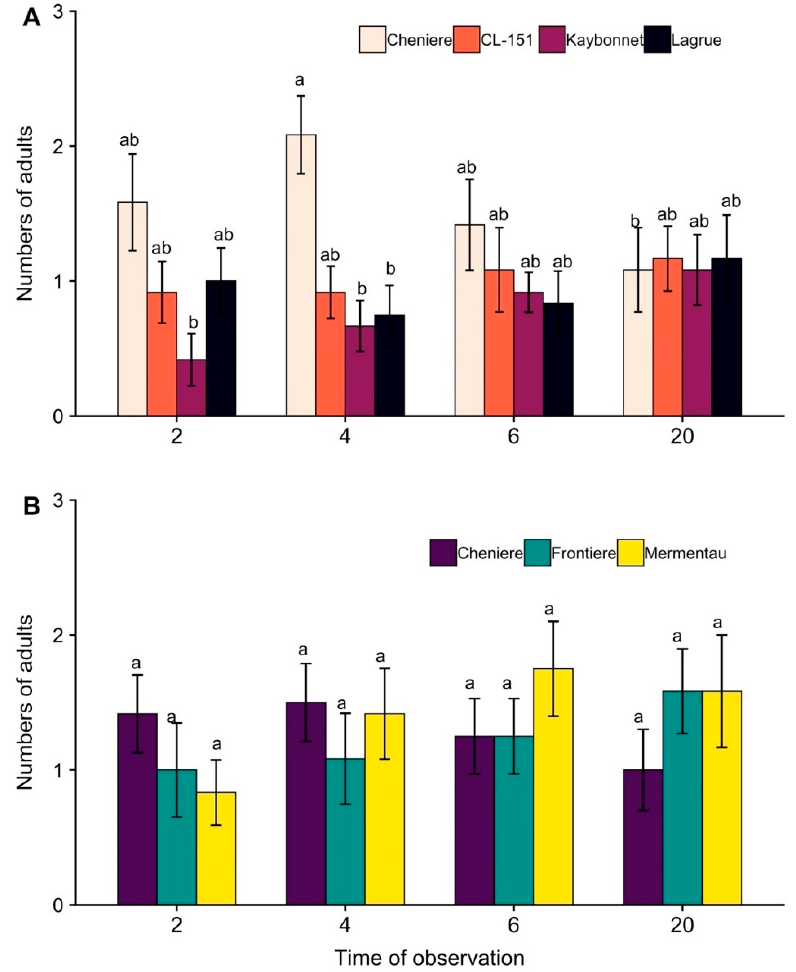
Figure 1. Mean ( ± SE) number of adult rice stink bugs, Oebalus pugnax , observed on different varieties of rice at 2, 4, 6, and 20 h post-adult release in ( A ) first group and ( B ) second group of varieties. In each figure, bars with different lowercase letters indicate significant differences among means ( p < 0.05).